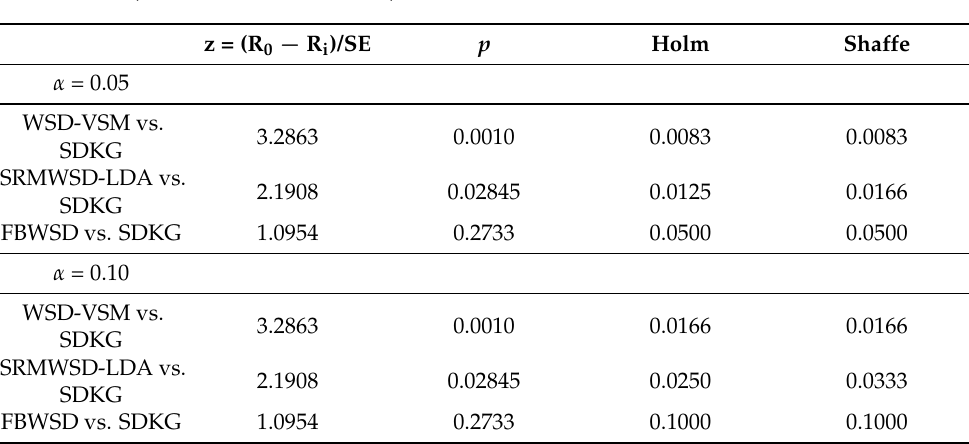
Table 5. Holm/Shaffer table for α = 0.05/ α =